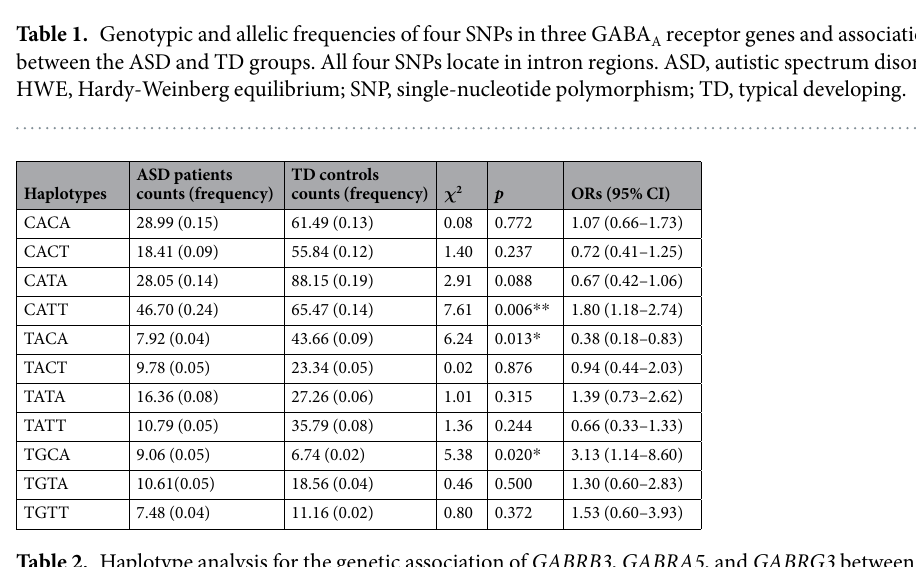
Table 2. Haplotype analysis for the genetic association of GABRB3 , GABRA5 , and GABRG3 between ASD patients and TD controls. Haplotypes with a frequency of < 0.03 in both groups have been dropped. Haplotypes were constructed with rs2081648-rs1426217-rs35586628-rs208129 in proper order. * p < 0.05; ** p < 0.01. ASD, autistic spectrum disorders; CI, confidence interval; ORs, odds ratios; TD, typical